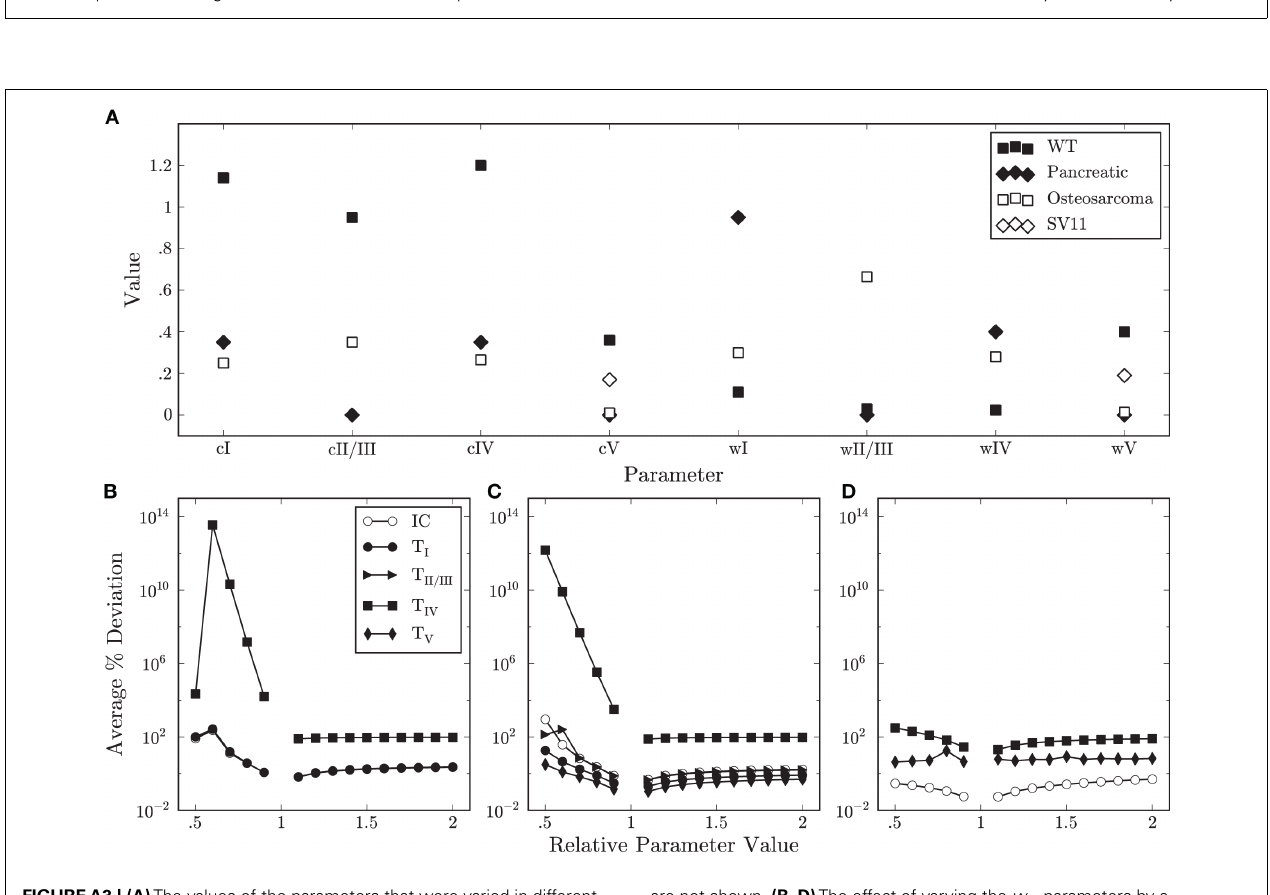
are not shown. (B–D) The effect of varying the w IV parameters by a multiplicative factor ( x -axes) on the variables is shown as an average percent deviation (APD) in the pancreatic, osteosarcoma, and wild-type cases ( y -axes).Very small APDs ( < 10 − 9 )